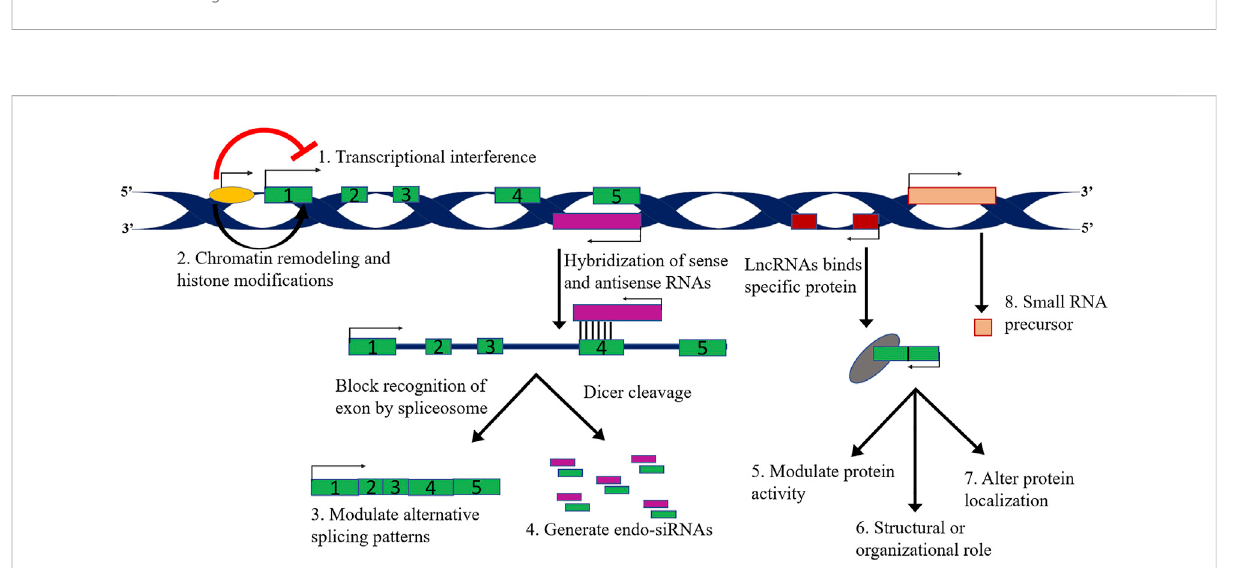
FIGURE 2 (A) Schematic representation of different genomic loci for noncoding RNAs. (B) Schematic representation of different types of long noncoding RNAs based on their genomic locus.